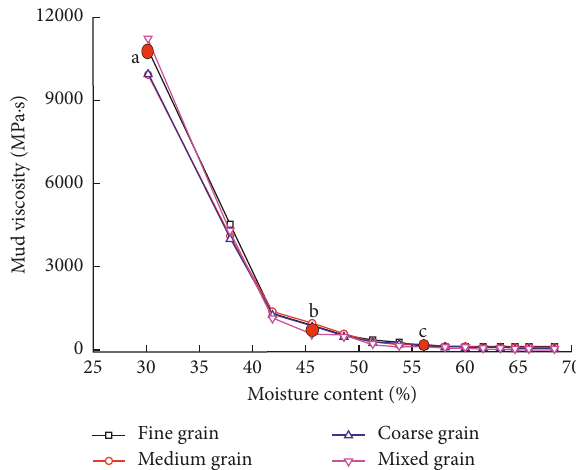
Figure 4: The curve of mud viscosity under different moisture content.